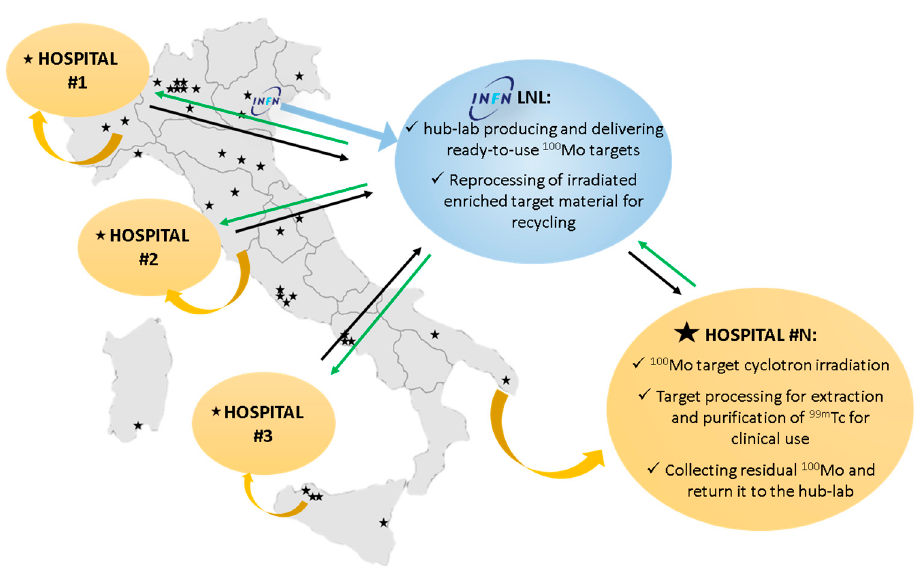
Figure 6. Schematic picture of the proposed “hub and spoke” approach for in-hospital cyclotron- 99m Tc production. The green arrows represent the distribution of ready-to-use 100 Mo targets produced by the hub-lab; the black arrows represent the used enriched target material returned from the hospitals to the hub-lab.